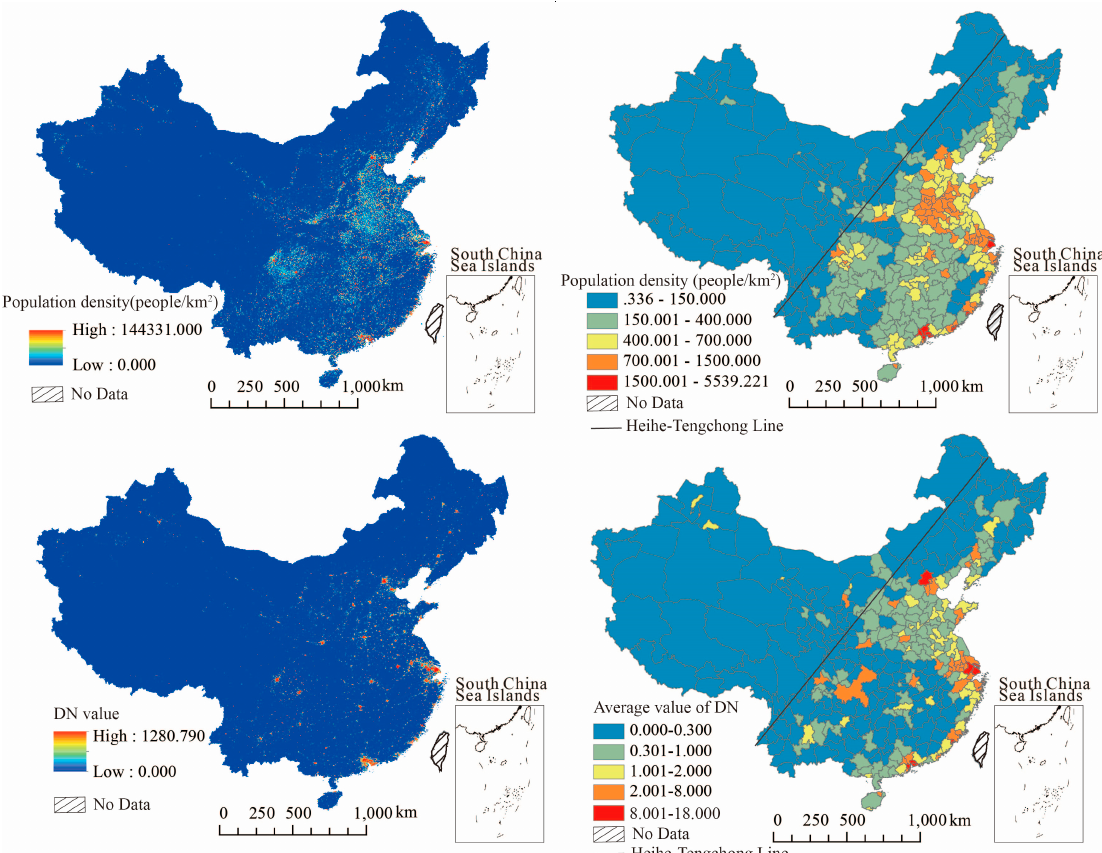
Figure 2. The distribution of population density and urbanization level. The top panel is population density and the bottom panel presents the urbanization level.